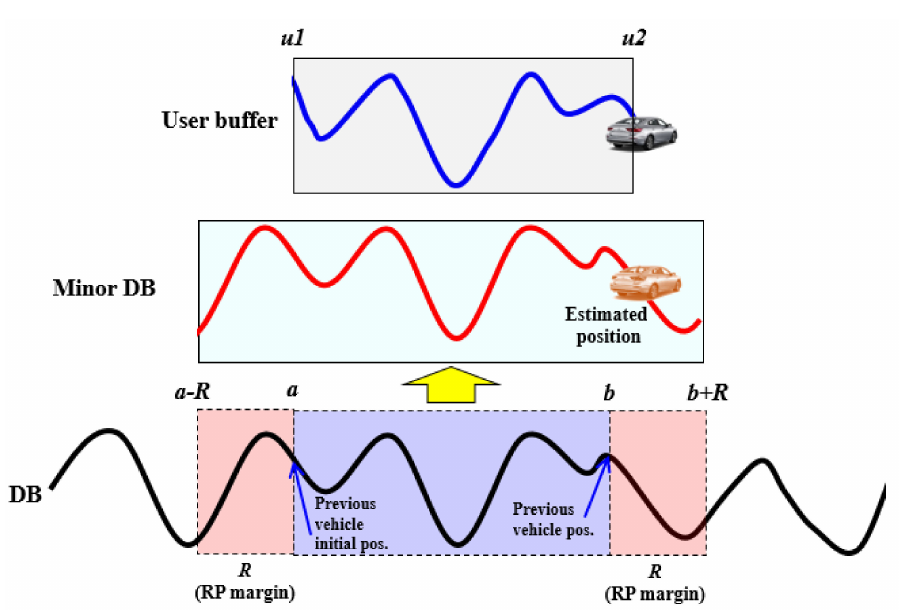
Figure 9. Minor DB generation using previous pair index and RP margin, R